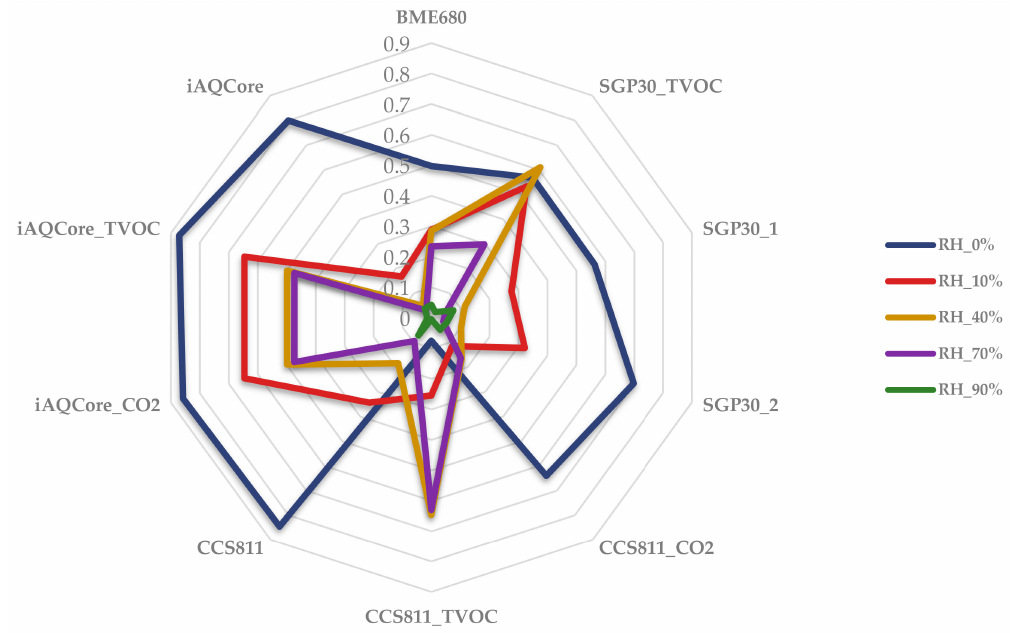
Figure 10. Radial diagram of the average responses of gas sensors at di ff erent relative humidity